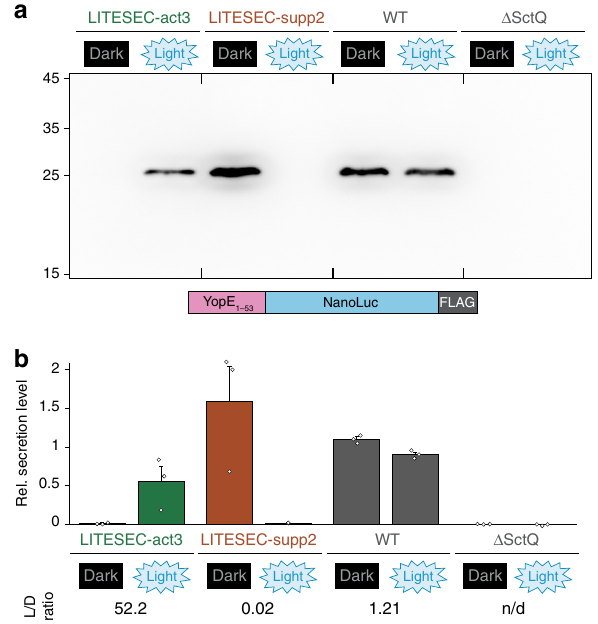
Fig. 6 Heterologous cargo can be exported in a light-dependent manner. a In vitro secretion assay showing light-dependent export of YopE 1-53 - NanoLuc-FLAG (see scheme below; exp. size, 28.7 kDa), in the indicated strains. Western blot using anti-FLAG antibodies for the culture supernatant of 3 × 10 8 bacteria per strain. Left side, molecular weight in kDa. b Quanti fi cation of light-dependent YopE 1-53 -NanoLuc-FLAG export by densitometric analysis of Western blots, normalized by average secretion of the wild-type control (WT), N = 3 densitometry values from independent experiments. Single data points indicated by circles, error bars display the standard error of the mean. L/D ratio, ratio of secretion under light and dark conditions. Source data are provided as a Source Data File. LITESEC-act3 strain showed an increase of secretion activity over 20 min in light conditions, and required 12 − 16 min to shut down secretion in the dark (Supplementary Fig. 8).